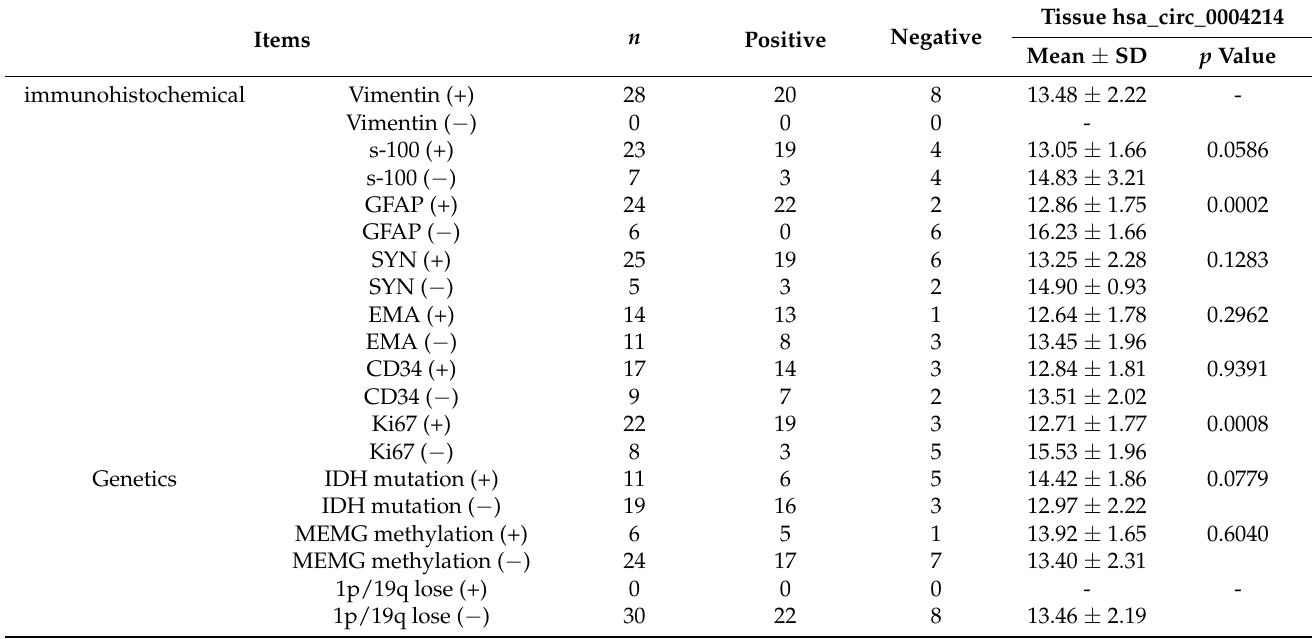
Table 6. Relationship of hsa_circ_0004214 levels with Genetics factors of patients with